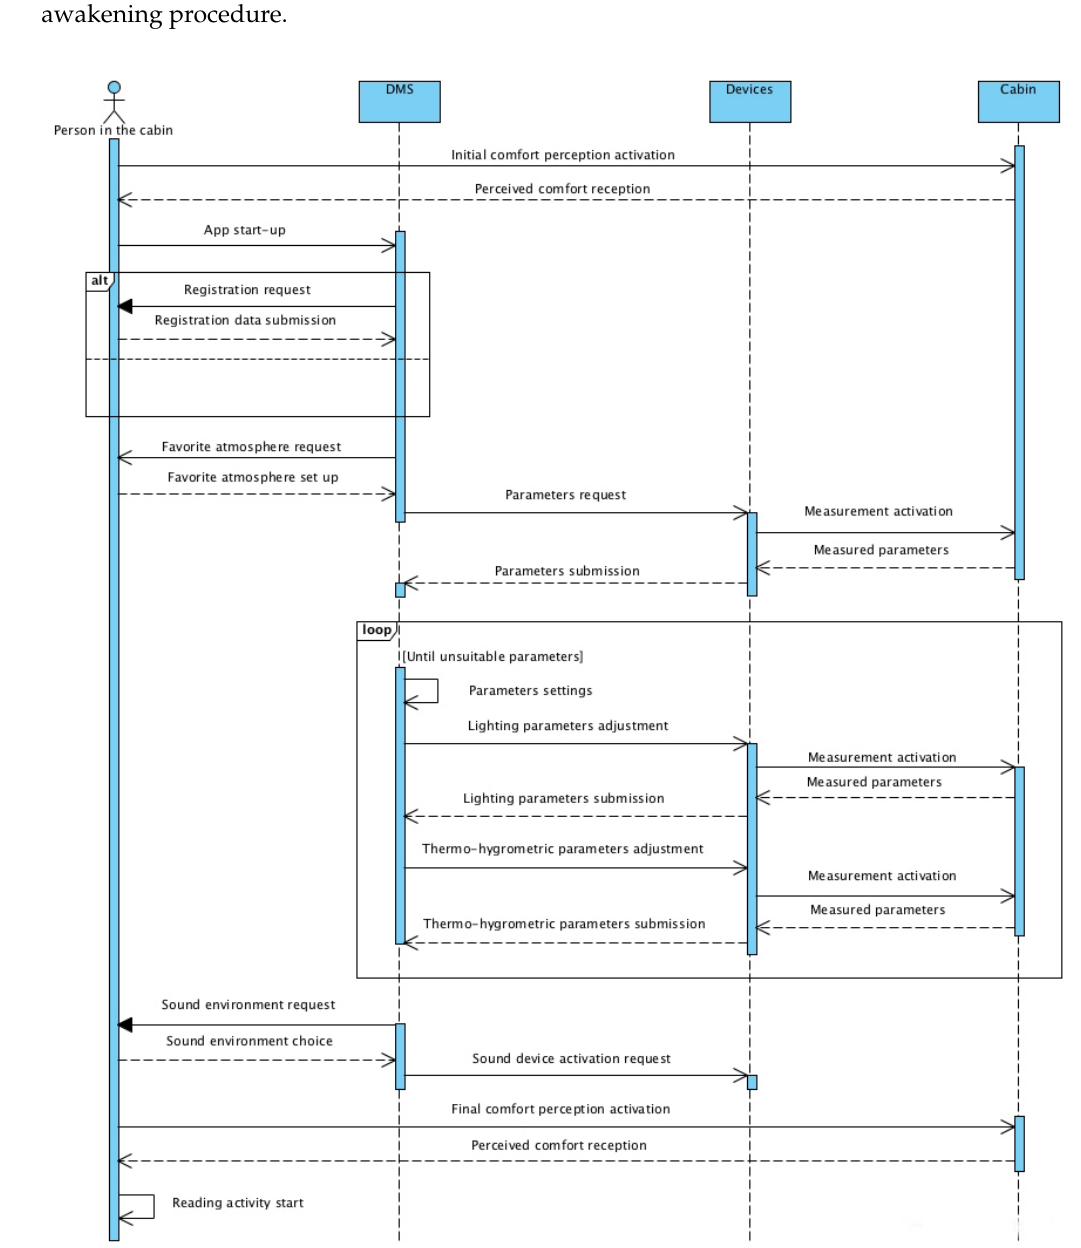
Figure 5. Sequence diagram for the Use Case